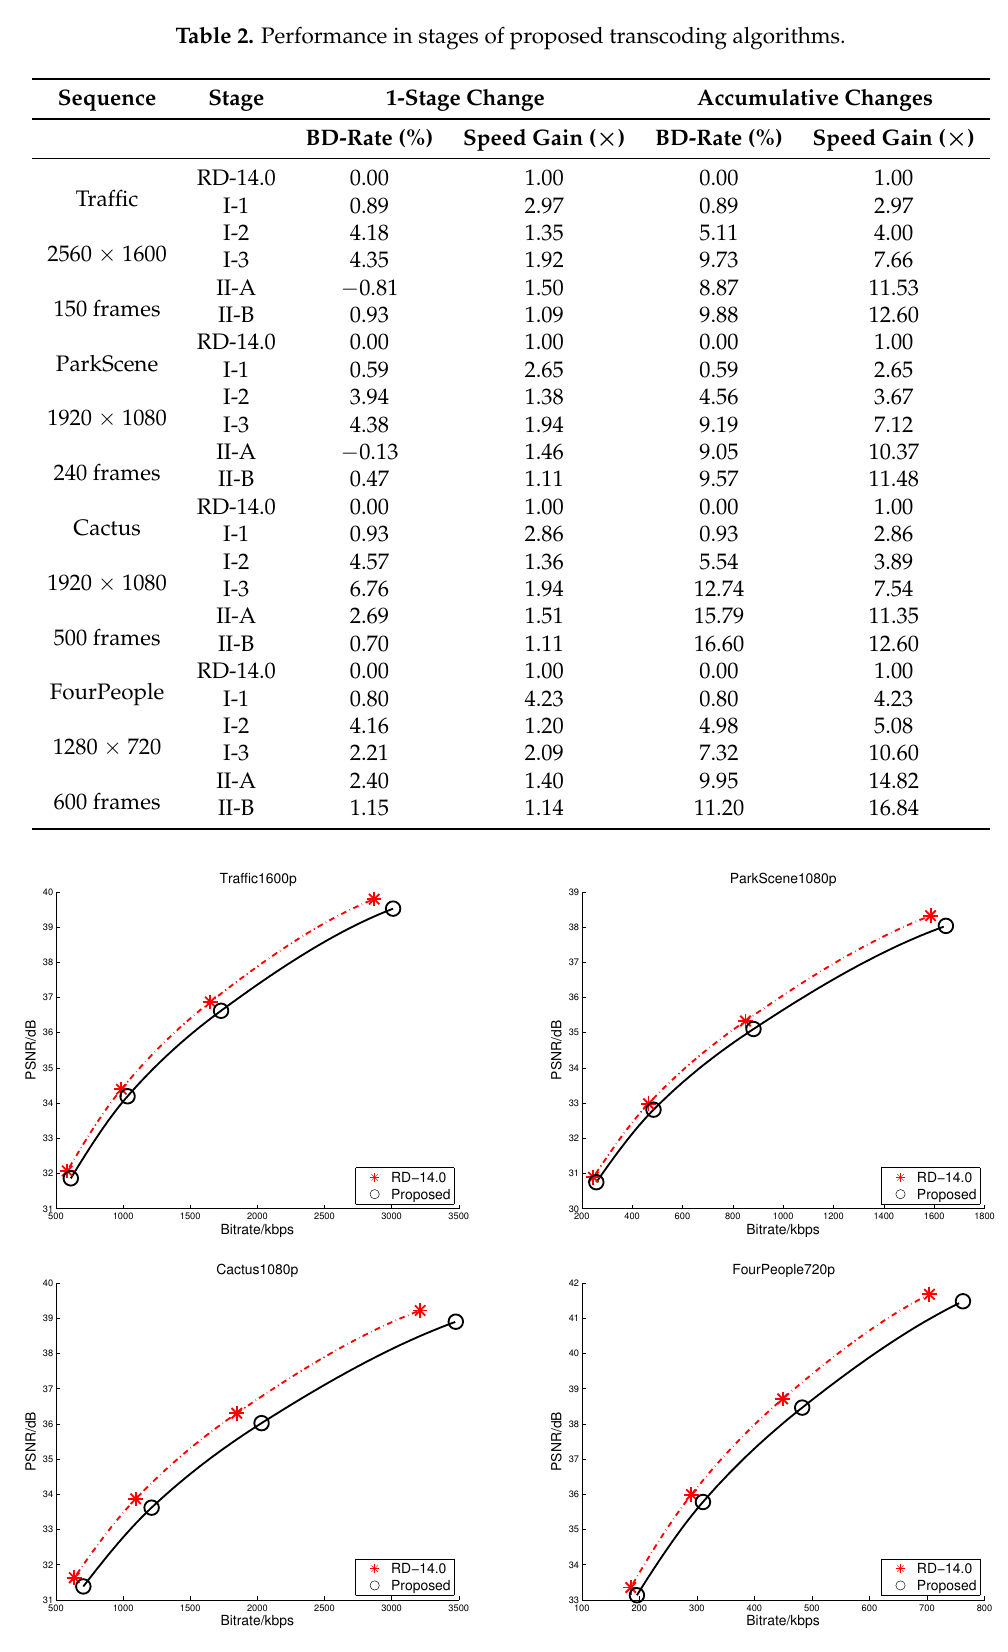
Figure 3. R-D Performance of Proposed Transcoder on HEVC Test